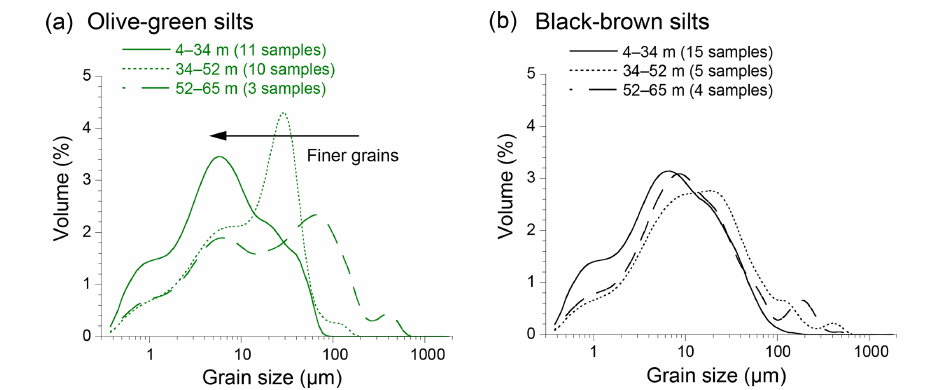
Figure 5. Mean grain-size distribution for the two main types of lake sediments at Darwin Crater. (a) Olive-green silts and (b) black-brown silts. Shifts to finer grain sizes in olive silts at 52 and 34m define three depth